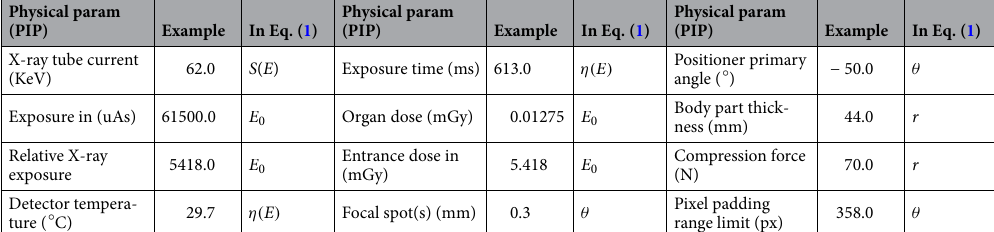
Table 1. Table of PIPs available for images from the three Hungarian hospitals. These physical parameters are measured automatically by the machine at the time of imaging. There were many more parameters available for each dataset but they were not all universally named between hospitals so were dropped to avoid false comparisons. Each parameter has a direct or indirect relation to a term in Eq. (1). Some of these parameters are derived from others thus should hold some redundant information, this further justifies the PCA space analysis, see Fig. 5.